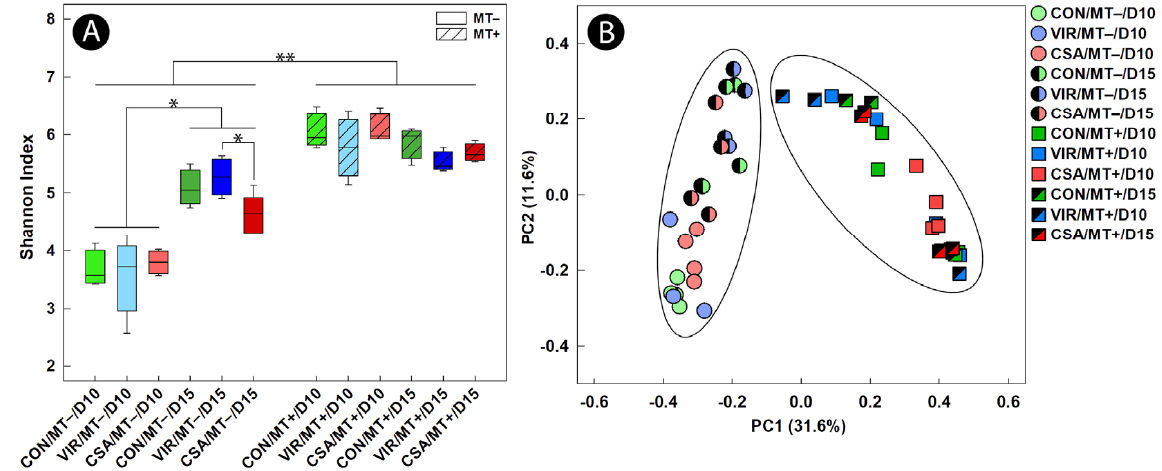
Figure 2. Diversity of bacteria in cecal digesta of broiler chicks administered an unamended starter diet (CON), a diet supplemented with virginiamycin (VIR), or a diet supplemented with the ceragenin, CSA-44 (CSA). Birds received a microbiota transplant (MT+) or buffer alone (MT–) on day 1 post-hatch. Samples were obtained 10 days post-hatch (D10) and 15 days post-hatch (D15). ( A ) Shannon index of α -diversity; ( B ) Bray–Curtis β -diversity. Ellipses in figure ( B ) distinguish MT– birds on the left and MT+ birds on the right. * p < 0.050. ** p < 0.010.